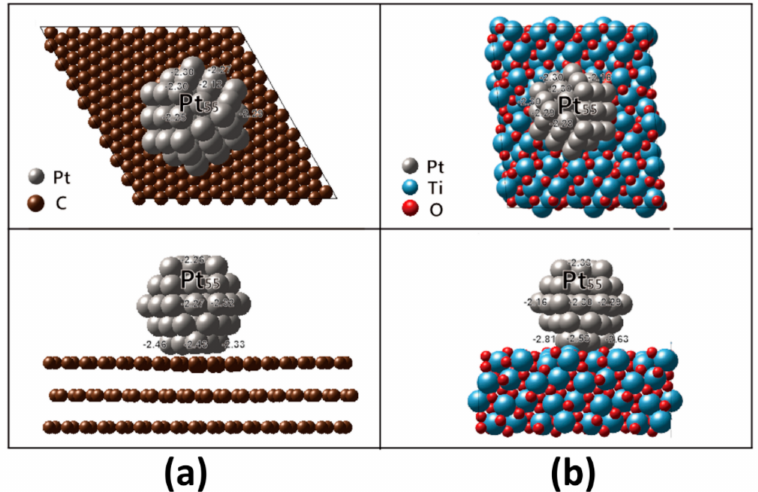
Figure 3. Top and side views of the relaxed Pt 55 nanoparticle cuboctahedron on ( a ) MPTO ( b ) graphite. The ε d values are given for each Pt atom in the Pt